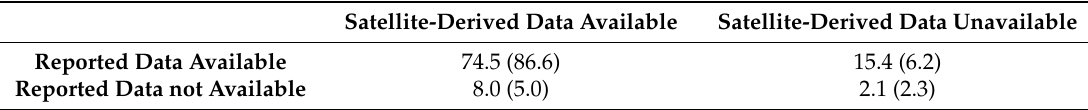
Figure 4. Distribution of the number of fire events larger than 200 ha dated using satellite data according to their burnt area extent. The bars represent burnt area intervals with irregular spacing due to the skewed fire size distribution and the value in the x-axis represents the lower bound of the interval. The black line represents cumulative burnt area (%). Table 2. Fraction of total burnt area (%) covered with data of wildfires’ start/end dates and ignitions (between brackets) for all study regions.